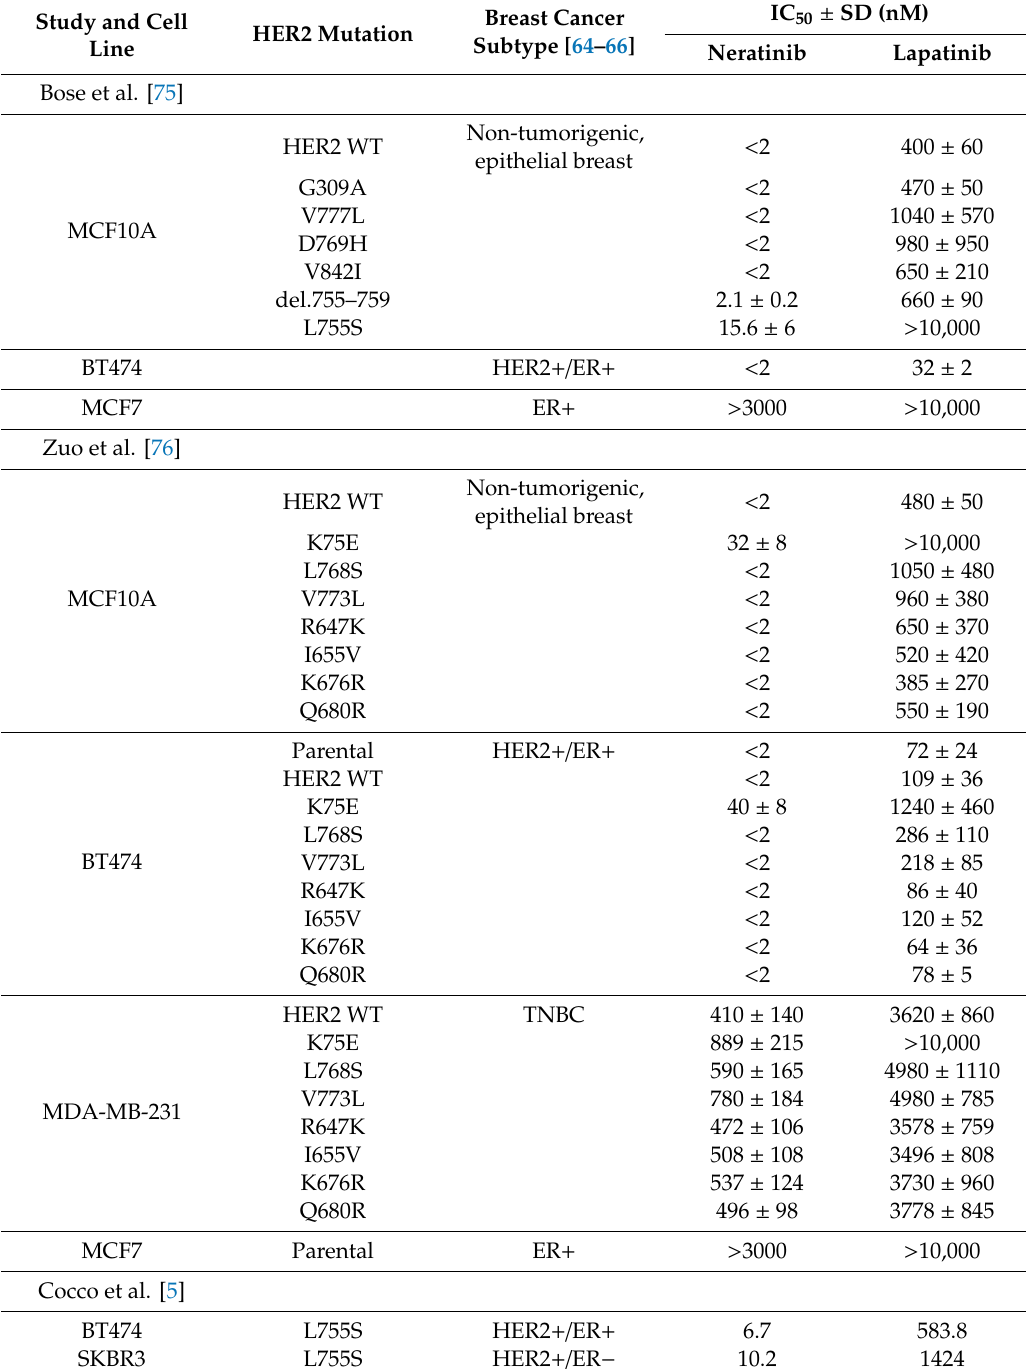
Table 3. IC 50 values for neratinib and lapatinib in cell-based assays: cell lines with HER2 mutations. Study and